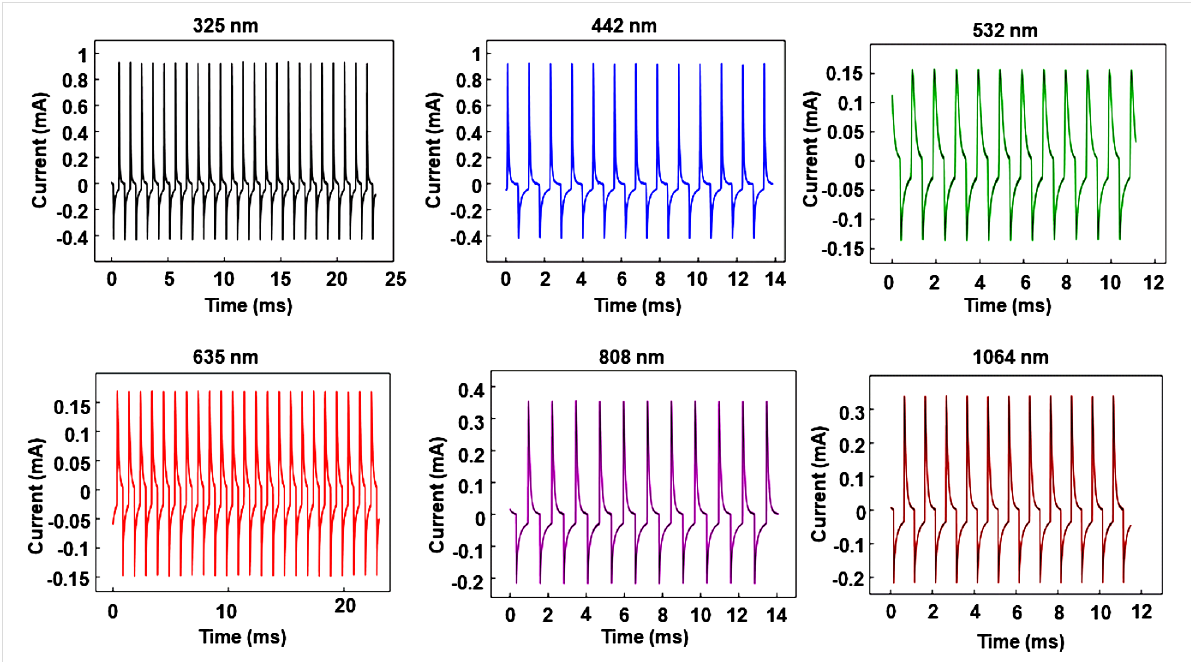
Figure 4: Dynamic response characteristics I–t characteristics of PDs under zero bias and different incident optical wavelengths in the range from UV to NIR.